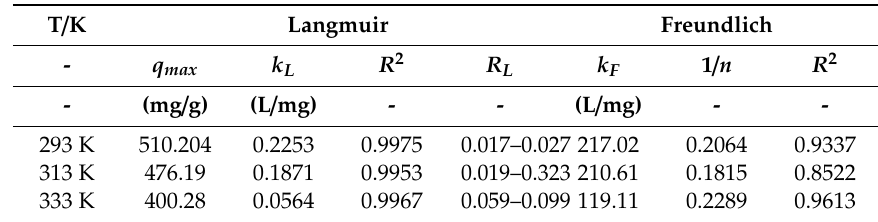
Figure 9. Langmuir plot ( a ) and ( b ) Freundlich plot. Table 2. Adsorption isotherm.